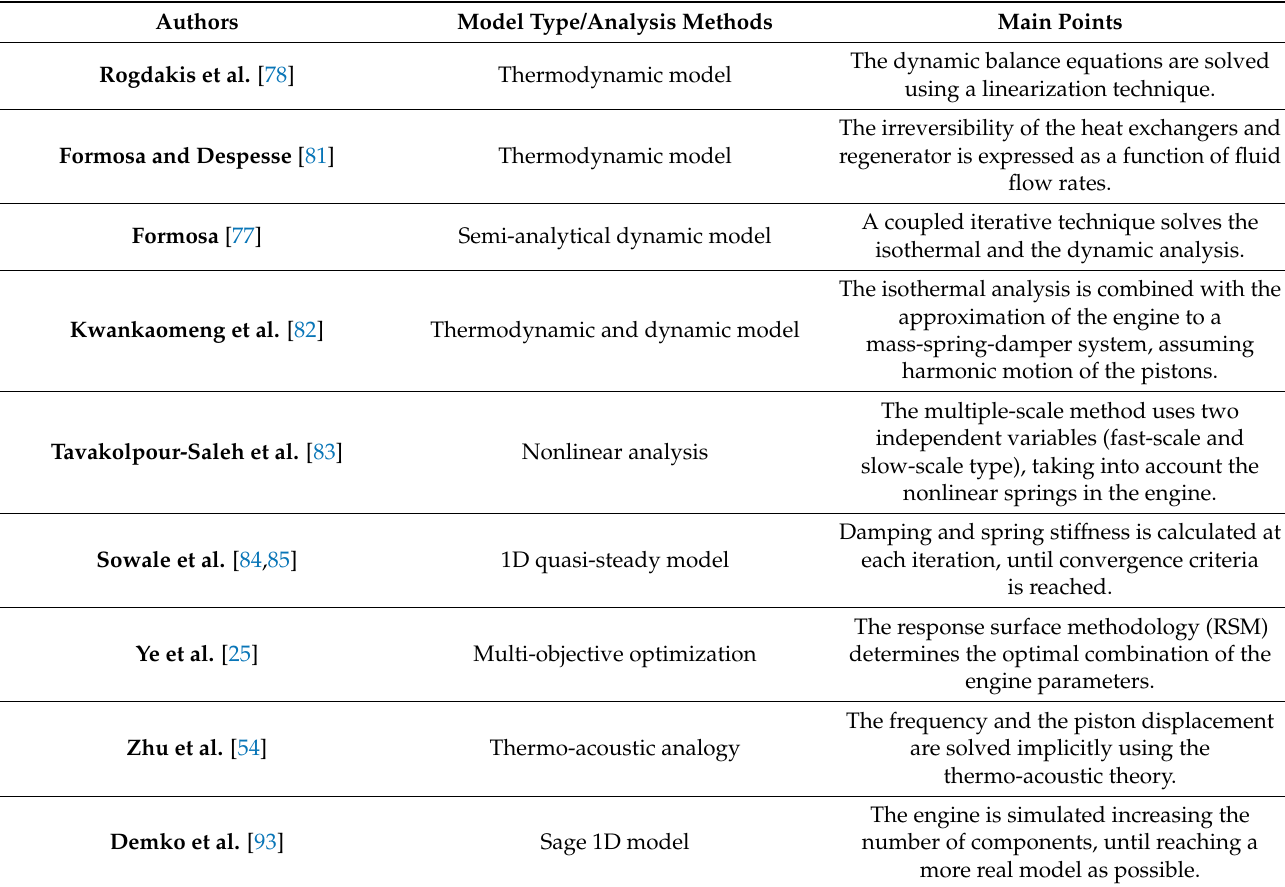
Table 3. Summary of thermodynamic and dynamic models on FPSE from the